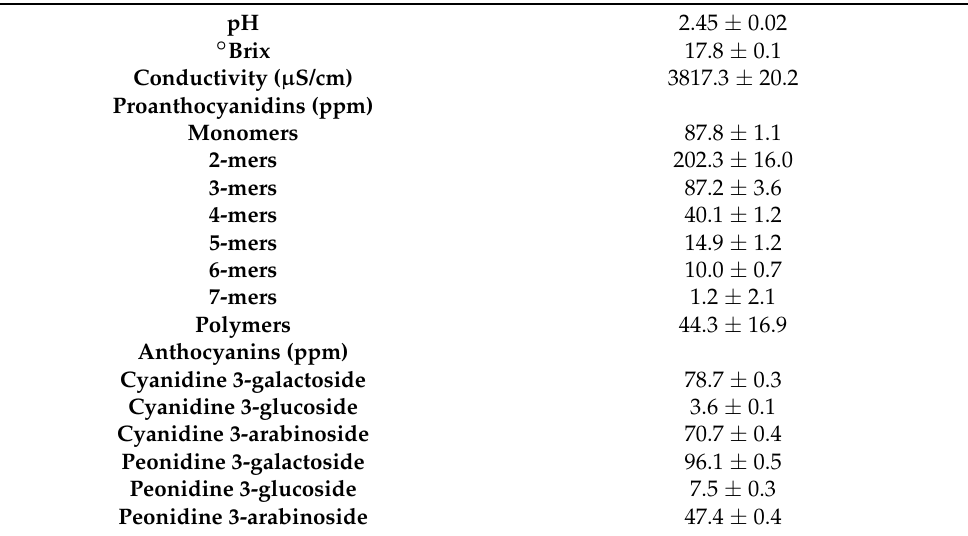
Table 1. Physico-chemical characteristics of cranberry juice.